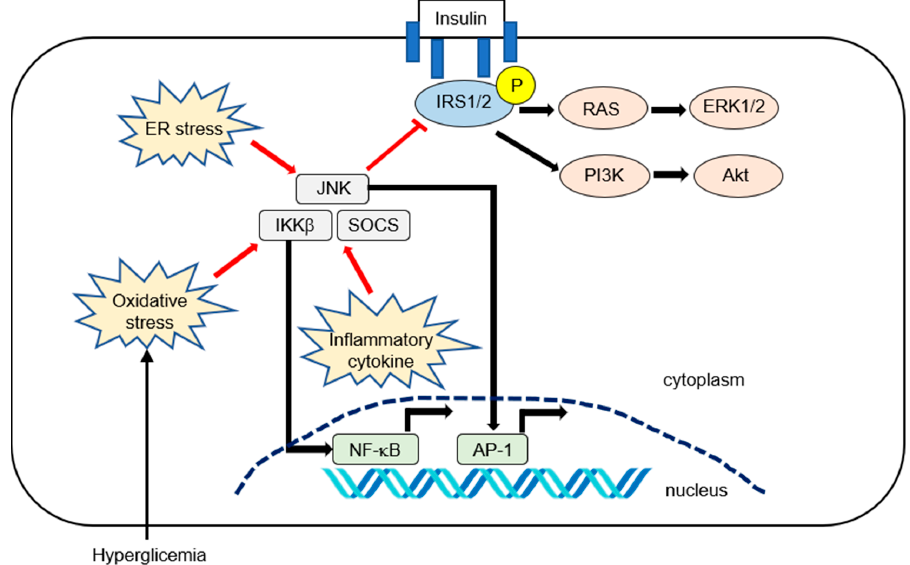
Figure 1. Summary of inflammatory pathways affecting hepatic insulin resistance (IR) in nonalcoholic fatty liver disease (NAFLD). Insulin activates its receptor, which results in tyrosine phosphorylation on the insulin receptor substrate (IRS1 and IRS2) and activation of downstream effector pathways, including the phosphatidylinositol 3-kinase (PI3K)-phosphoinositide-dependent kinase (PDK)- protein kinase B (AKT) and the RAS − extracellular-signal-regulated kinase (ERK) pathways